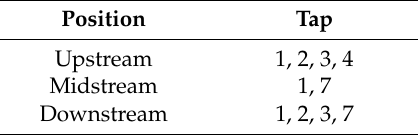
Table 2. Pressure taps exploited for the present campaign.